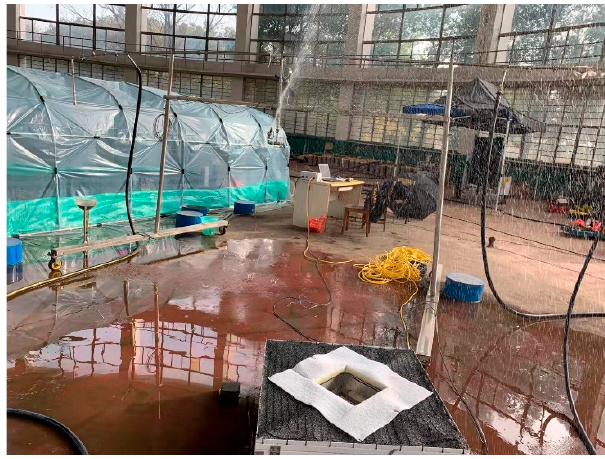
Figure 2. Experimental setup in the indoor laboratory.